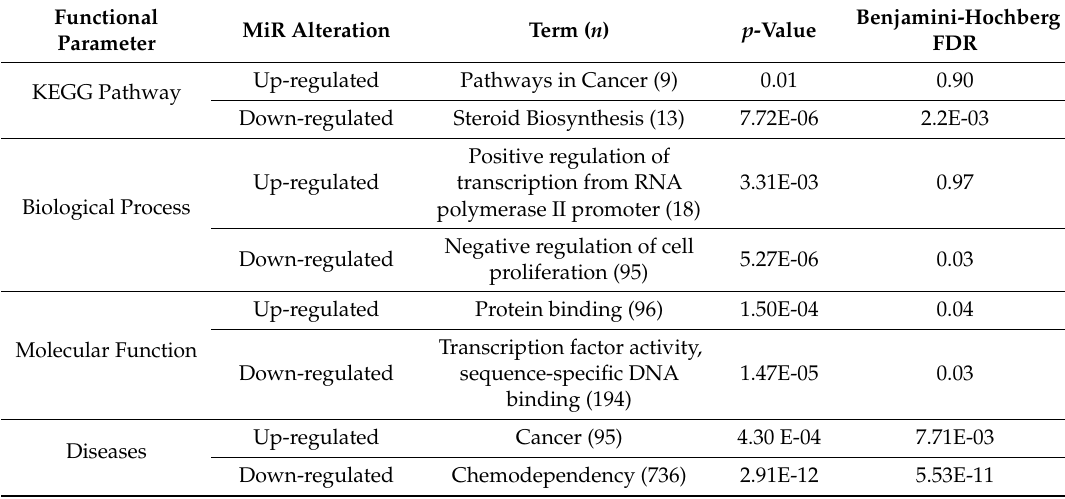
Table 4. Top pathways, biological processes, and molecular functions and diseases for altered MiR. Target Genes following vitamin D Treatment of CAL-27 and SCC-25 head and neck cell